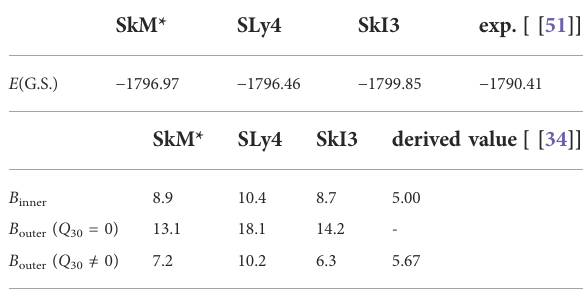
TABLE 1 Calculated ground state energies, fi ssion barrier heights, experimental, and derived values (MeV) of 236 U. SkM* SLy4 SkI3 exp. [ [51]]